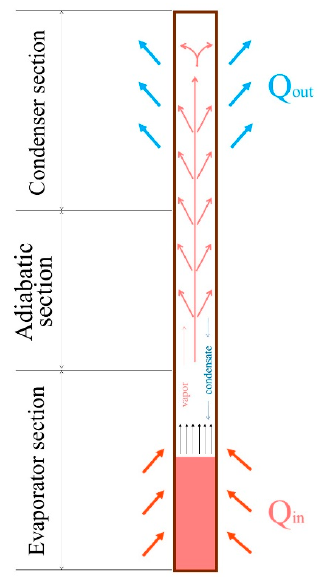
Figure 1. Cross section and working principle of a two-phase closed thermosyphon [9].